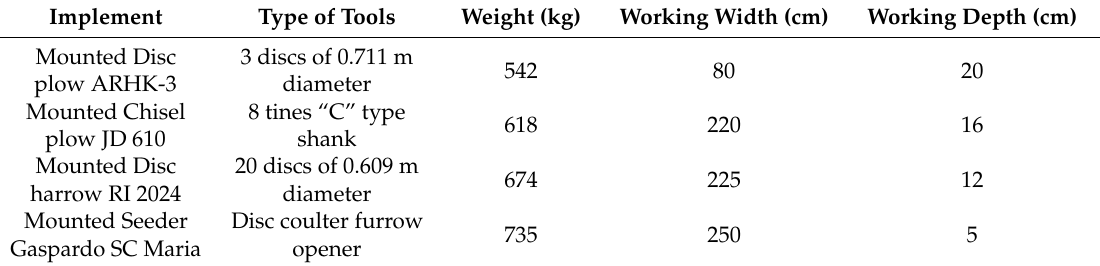
Table 1. Specifications of the implements used for the tillage